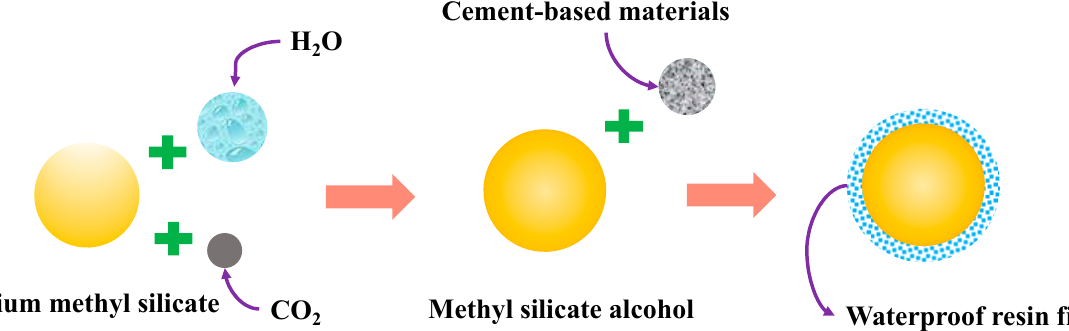
Figure 11. Sodium methyl silicate action model.